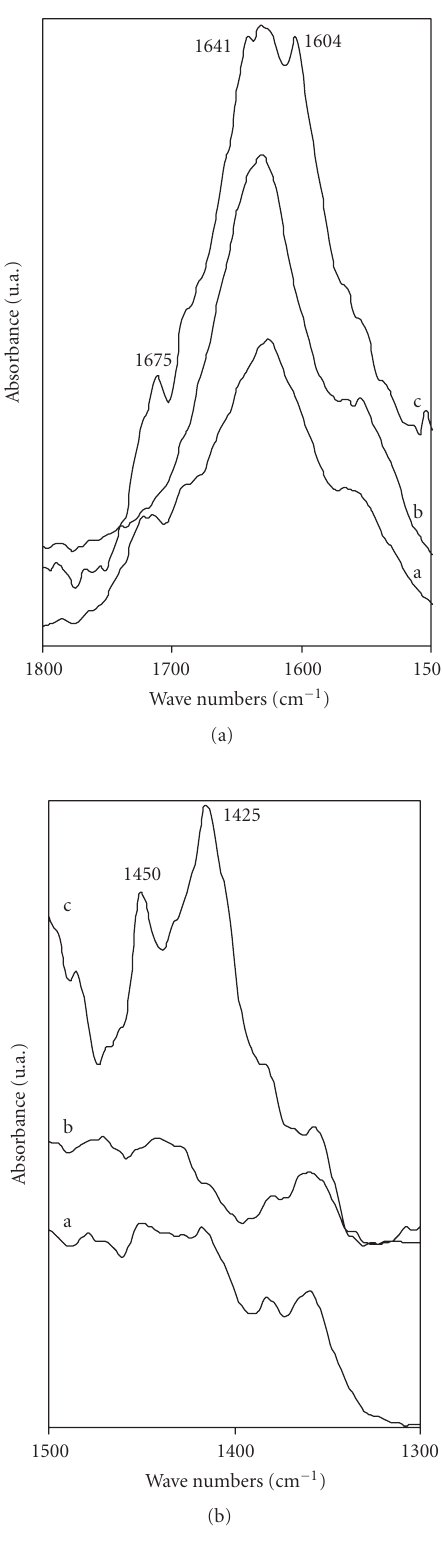
Figure 9: FT-IR spectra of TiO 2 particles regenerated in air flow under UV irradiation for 6 hours (a), fresh aggregates of TiO 2 par- ticles (b), and deactivated aggregates of TiO 2 particles (c) in the region between 1800–1300 cm − 1 . The spectra have been displaced vertically for